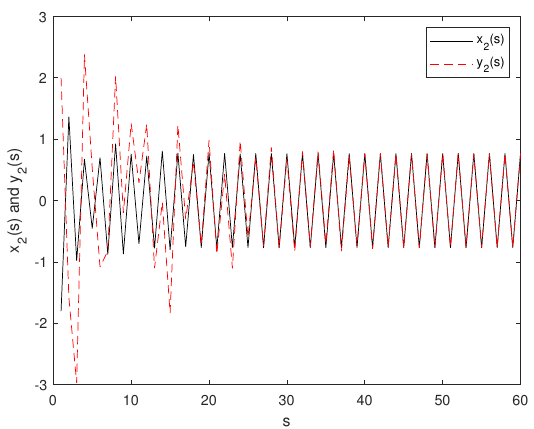
Figure 7. Trajectory curves of x 2 ( s ) and y 2 ( s ) with controller.